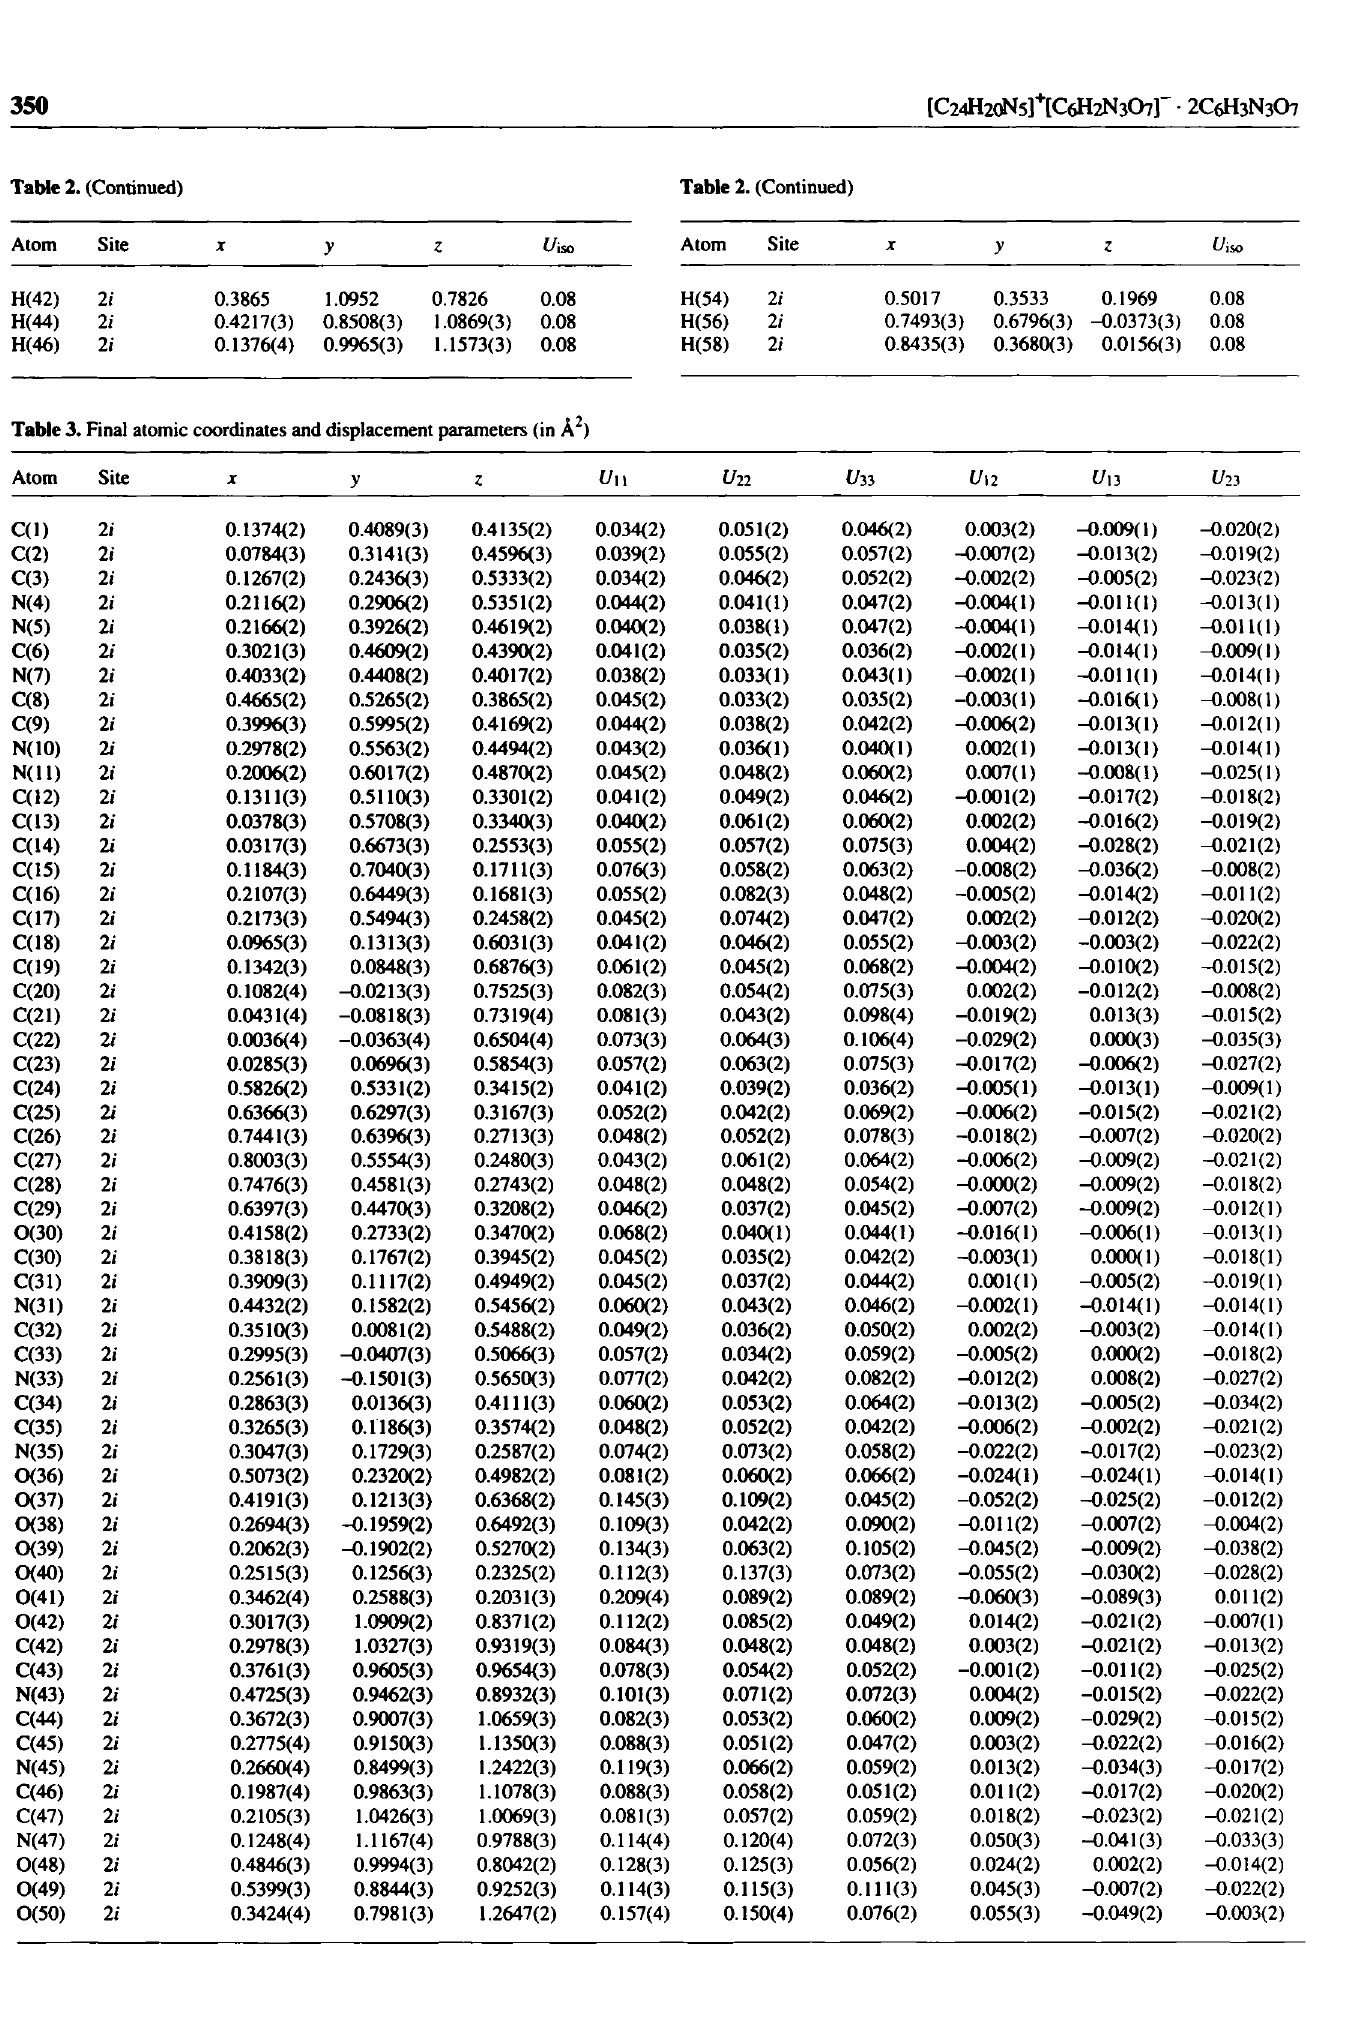
Table 3. Final atomic coordinates and displacement parameters (in